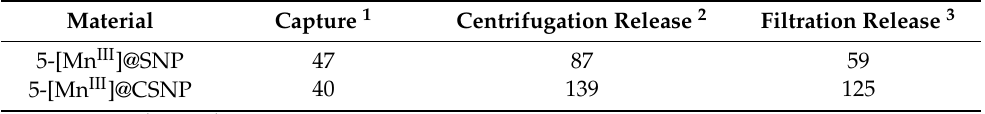
Table 3. Evolution of the integrate of the emitted intensity measured for all types of nanoparticles loaded with Mn III complexes.